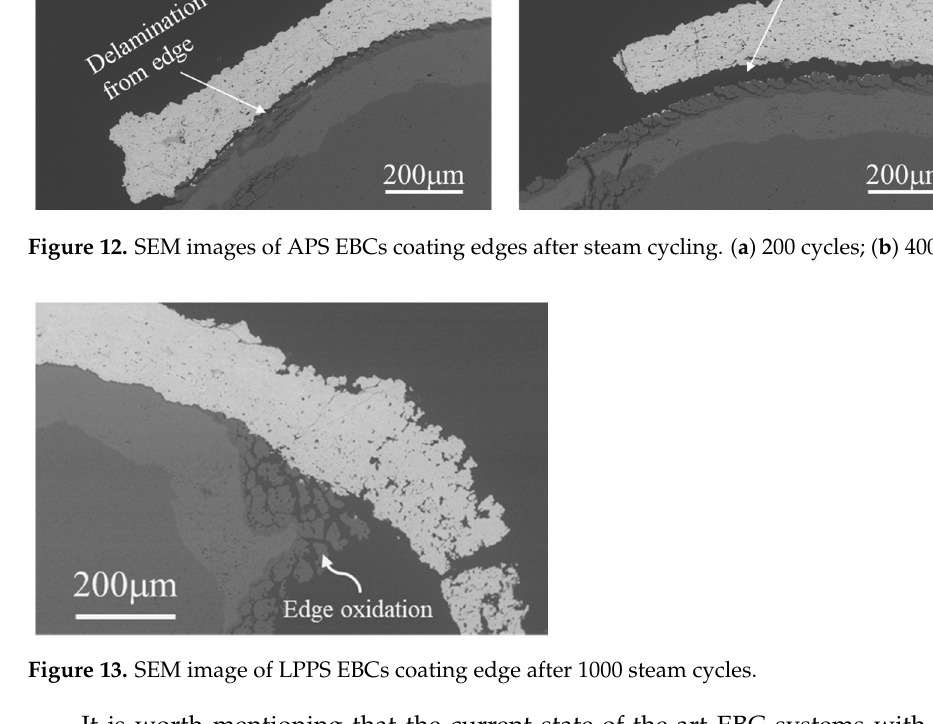
Figure 13. SEM image of LPPS EBCs coating edge after 1000 steam cycles. It is worth mentioning that the current state-of-the-art EBC systems with silicon as the bond coat are limited to the application/testing temperature of ≈ 1316 °C due to the low melting temperature of silicon ( T m = 1410 °C). For next-generation EBC-CMC, the temperature of the EBC-CMC interface is expected to exceed the melting point of Si; therefore, new bond coat materials are needed. Our current work demonstrated that the LPPS process has the capability for the deposition of highly durably dense EBCs due to the high particle temperature and velocity, which would be the preferred process for the deposition of next-generation EBCs with an advanced bond coat. 4. Conclusions Yb 2 Si 2 O 7 /Si bilayer environmental barrier coatings (EBCs) were produced by air plasma spray (APS) and low-pressure plasma spray (LPPS) processes. LPPS EBCs showed denser and crack-free microstructures and higher bonding strength than APS EBCs. Thermal cycling behaviors were tested in air and in steam atmosphere at 1316 °C for both APS and LPPS EBCs. There is no coating failure in air atmosphere for both APS and LPPS